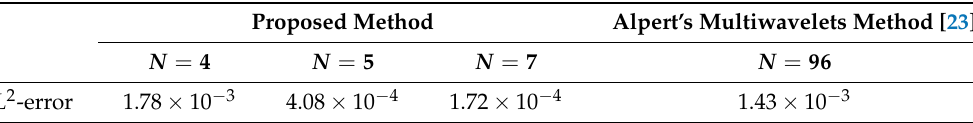
Table 1. The comparison between Alpert’s multiwavelets method and the proposed method taking µ = 5/6 and Chebyshev nodes for Example 1.